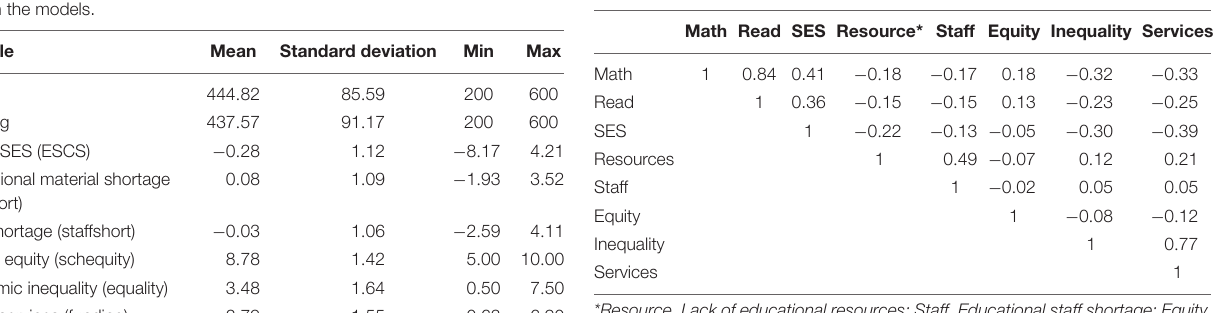
TABLE 2 | Pearson correlation coefficients for variables used in the